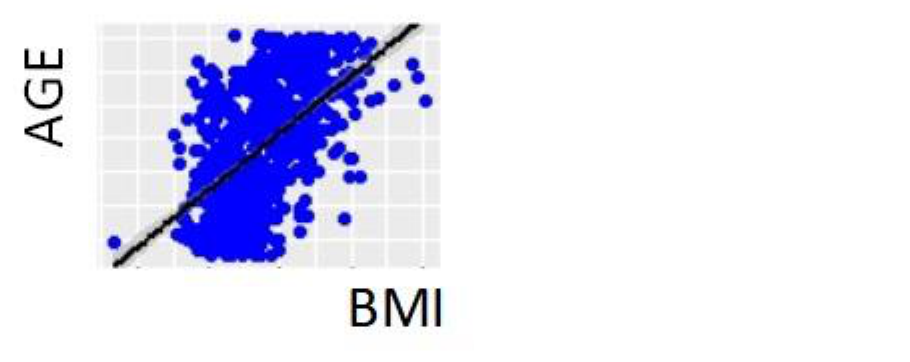
Figure 3. Dispersion diagram of age and BMI. Positive strong correlation between age and BMI. Correlation coefficient 0.549 ( p Value < 0.001).